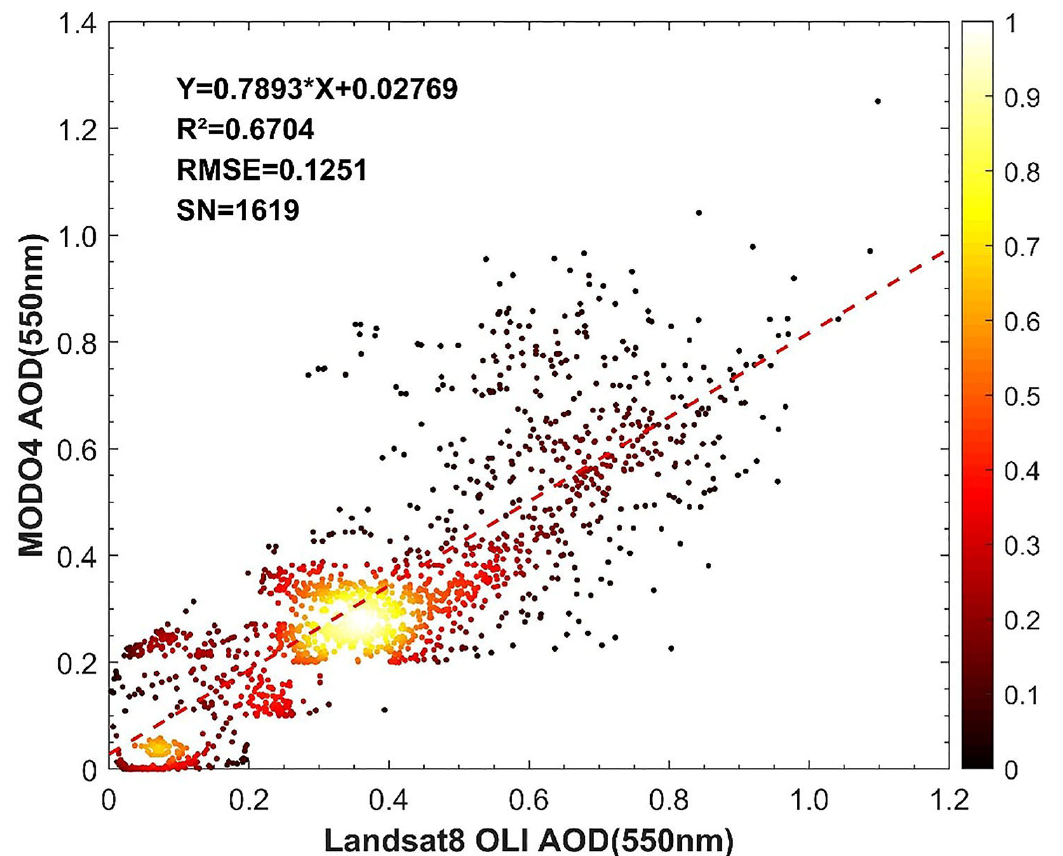
Figure 9. Relationship between Landsat8 OLI AOD and MODO4 AOD at 550 nm. RMSE and SN represent the root mean square error and total sample number of matched pixels, respectively.